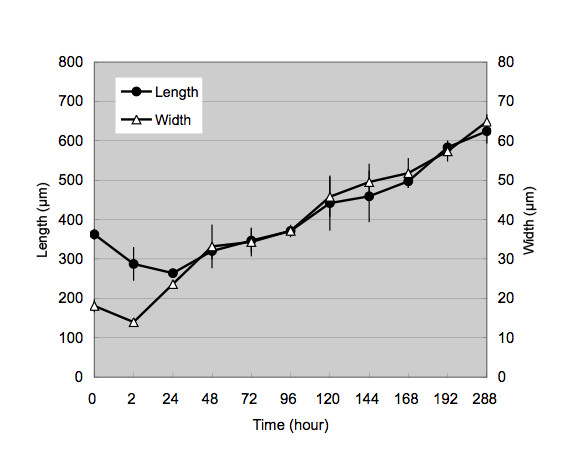
Chronological changes of body sizes. The chronological changes of Gnathostoma spinigerum body sizes in Mesocyclops aspericornis.